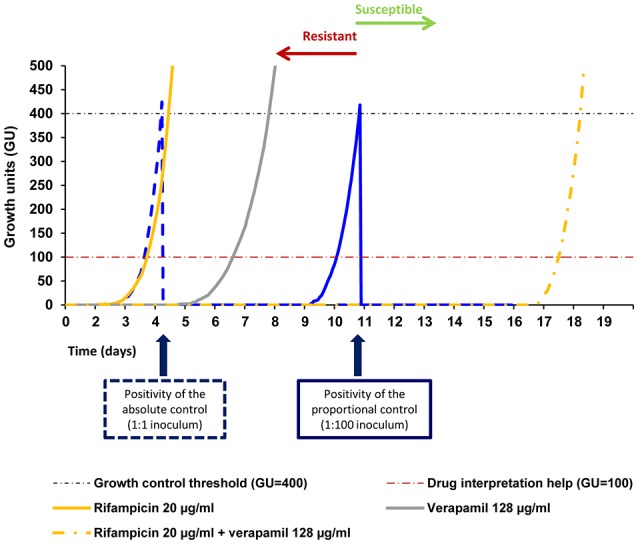
Quantitative drug susceptibility testing of rifampicin for the strain MtbPT11, in the presence or absence of verapamil. Quantitative drug susceptibility testing of isoniazid was conducted using the BACTEC 960 system and the Epicenter V5.80A software equipped with the TB eXIST module. In the Figure is presented the result of the testing for the strain MtbPT11 at 20 μg/ml of rifampicin alone (full orange curve) and rifampicin at 20 μg/ml in the presence of verapamil at half MIC (dashed orange curve). Verapamil alone does not inhibit the growth of the strain (gray curve). Absolute control is given by the dotted blue curve (undiluted strain 1:1) and the proportional control is given by the continuous blue curve (strain diluted 1:100). At the time of growth of the proportional growth control (GU = 400—black dashed line), the comparison between this tube and the tubes containing the drugs(s) was performed. If the GU of the tubes containing the drug were >100 (red dashed line), they were considered to be resistant to that concentration. If the GU of the tube containing the drug was <100 they were considered susceptible.